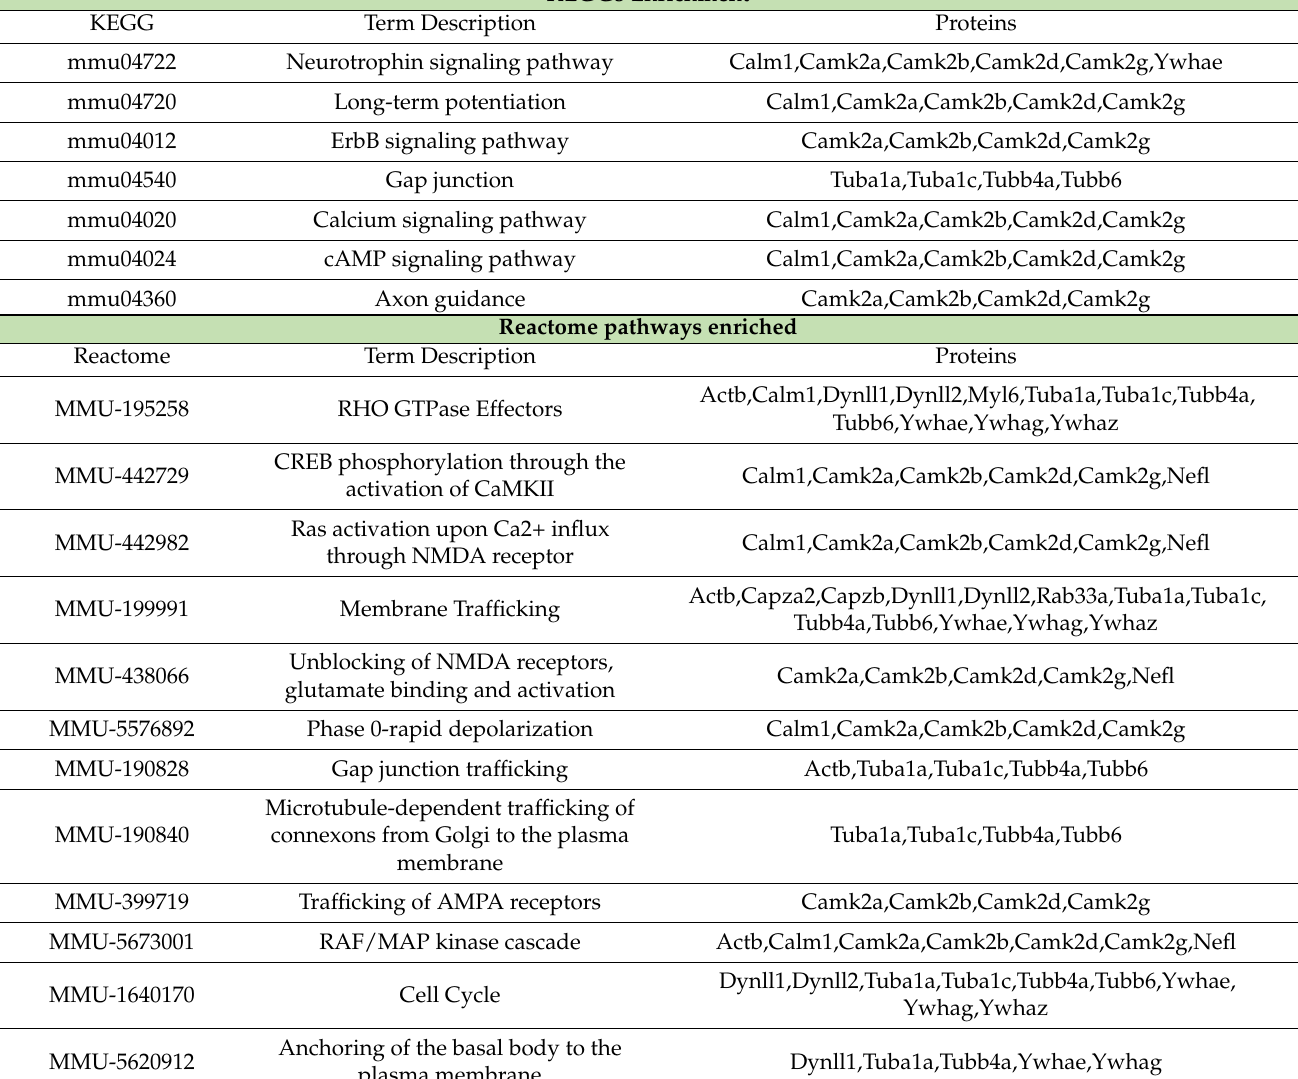
Table 3. Kyoto Encyclopedia of Genes and Genomes (KEGGS) and The Reactome pathways enriched in NCAM2